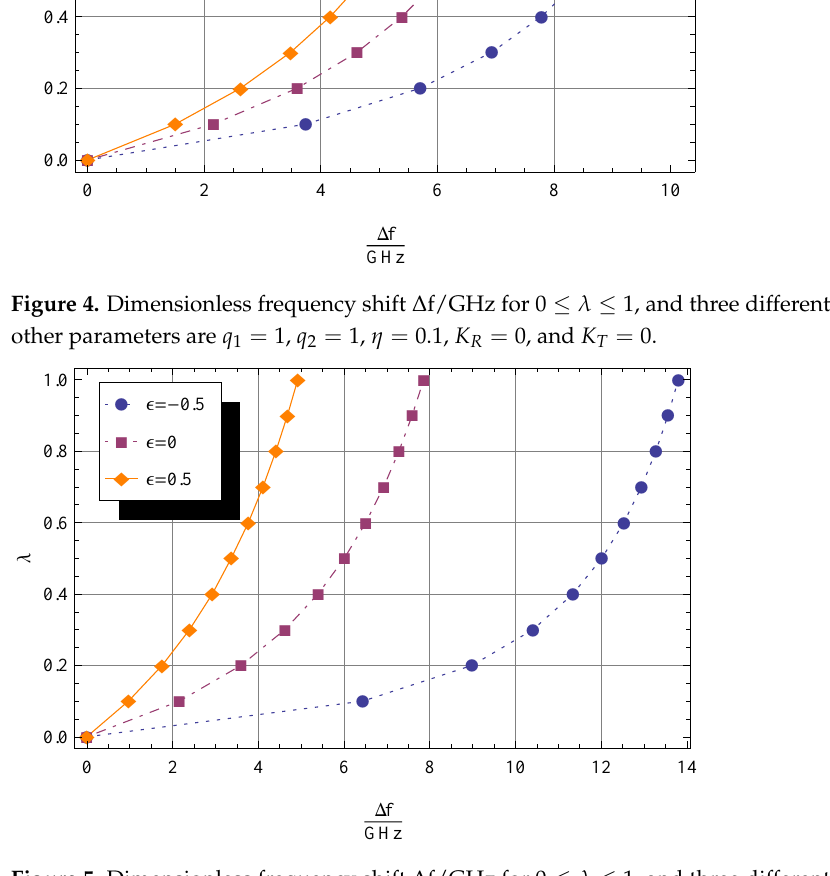
Figure 5. Dimensionless frequency shift ∆ f/GHz for 0 ≤ λ ≤ 1, and three different values of (cid:101) . The other parameters are q 1 = 2, q 2 = 2, η = 0.1, K R = 0, and K T =